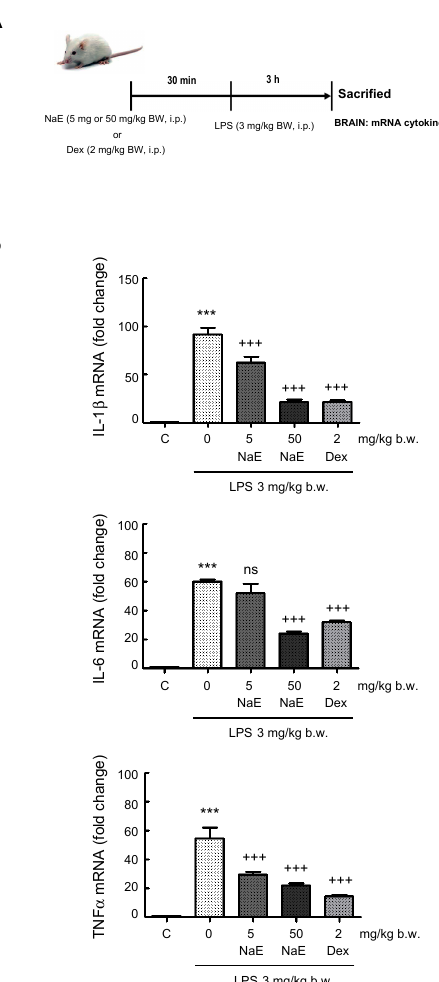
Figure 7. Effect of NaE extract on LPS-induced neuroinflammation in mice. ( A ) Experimental steps. Mice were treated with vehicle, dexamethasone (2 mg/kg) (Dex), NaE extract (50 mg/kg) or NaE extract (5 mg/kg) 30 min prior to intraperitoneal injection of LPS (3 mg/kg). ( B ) IL-1 β , IL-6 and TNF- α mRNA was determined in brain tissue at 3 h after i.p. LPS injection by RT-qPCR analysis. Values were calculated using the ∆∆ Ct method normalized to GAPDH and the control group (only vehicle administration) and expressed as mean ± SD (n = 6). *** p < 0.001 vs. the control group; and +++ p < 0.001 vs. the LPS-treated group.